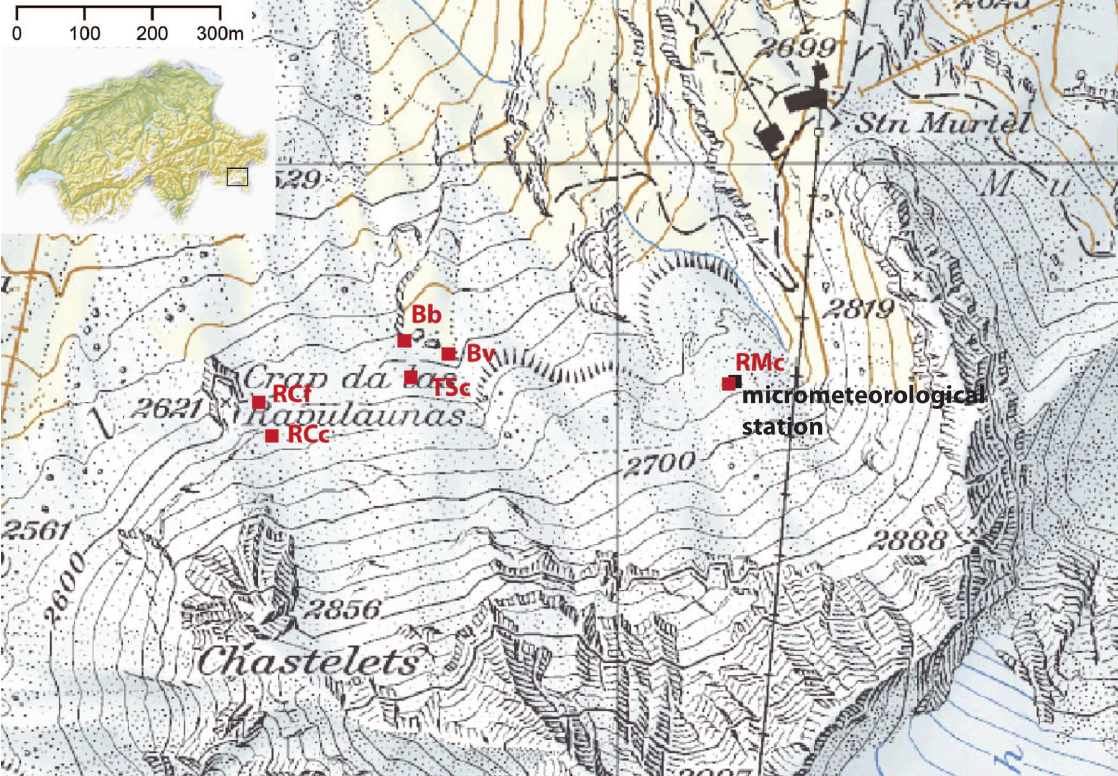
Fig. 1. Investigation area Murt`el-Corvatsch, Eastern Swiss Alps. The 5 shallow boreholes are indicated by its material: Bb=bare bedrock, Bv=vegetated bedrock, TSc=talus slope (coarse blocky), RCf=rock glacier Chastelets (fine-grained), RCc=rock glacier Chastelets (coarse blocky) and RMc rock glacier Murt`el (coarse blocky)